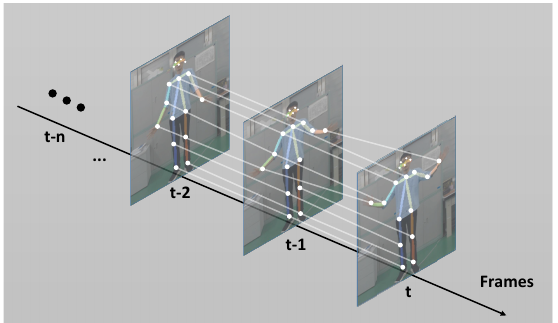
Figure 11. Illustration of the ST-GCN [19], where the spatial temporal graph of a skeleton sequence are used to classify the action of a human.